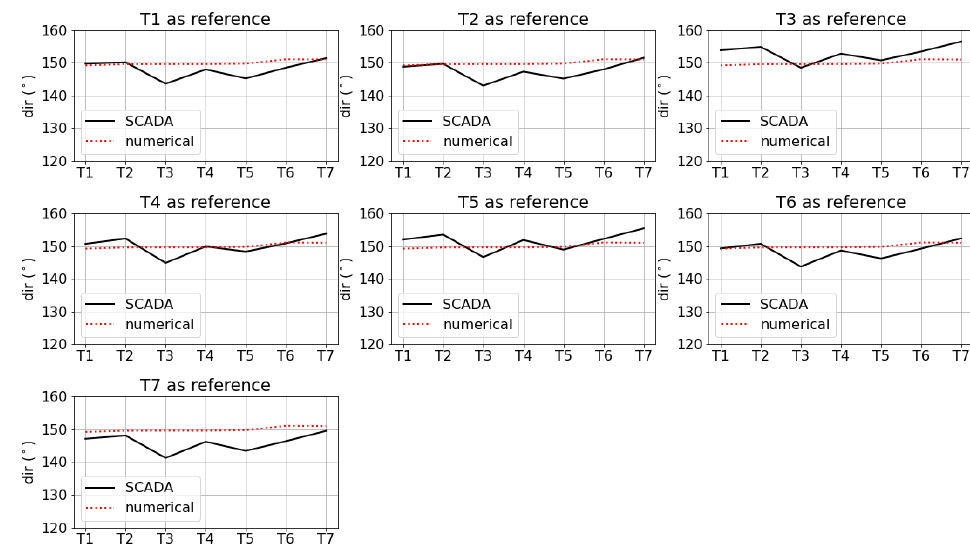
Figure 19. Comparison between simulation and measurements regarding the average wind direction, where each wind turbine is selected iteratively for tuning the